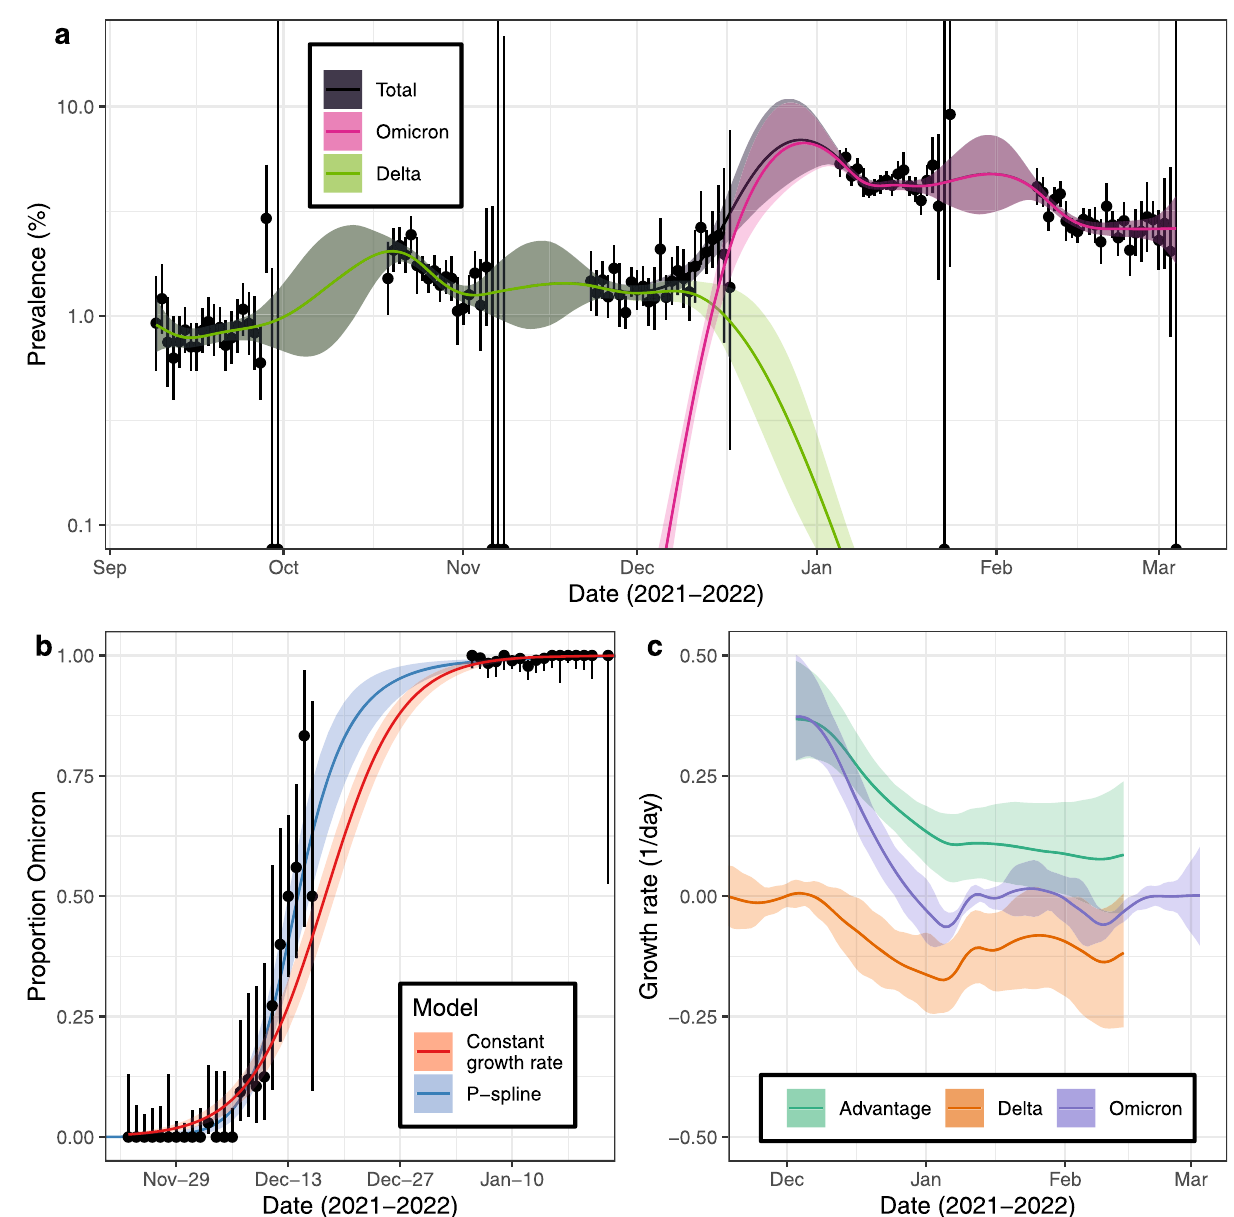
Fig. 1 | Competition of Omicron and Delta variants. a Modelled prevalence of SARS-CoV-2variantsOmicronandDeltainEnglandestimatedusingamixed-effects BayesianP-splinemodel.Estimatesofprevalenceareshownwithacentralestimate (solid line) and 95%(shadedregion) credible intervals. Daily weightedestimates of mean prevalence (points) are shown with 95% credible intervals (error bars). b Modelled proportions of lineages identi fi ed as Omicron in England, estimated usingBayesianlogisticregression(red)andusingamixed-effectsBayesianP-spline